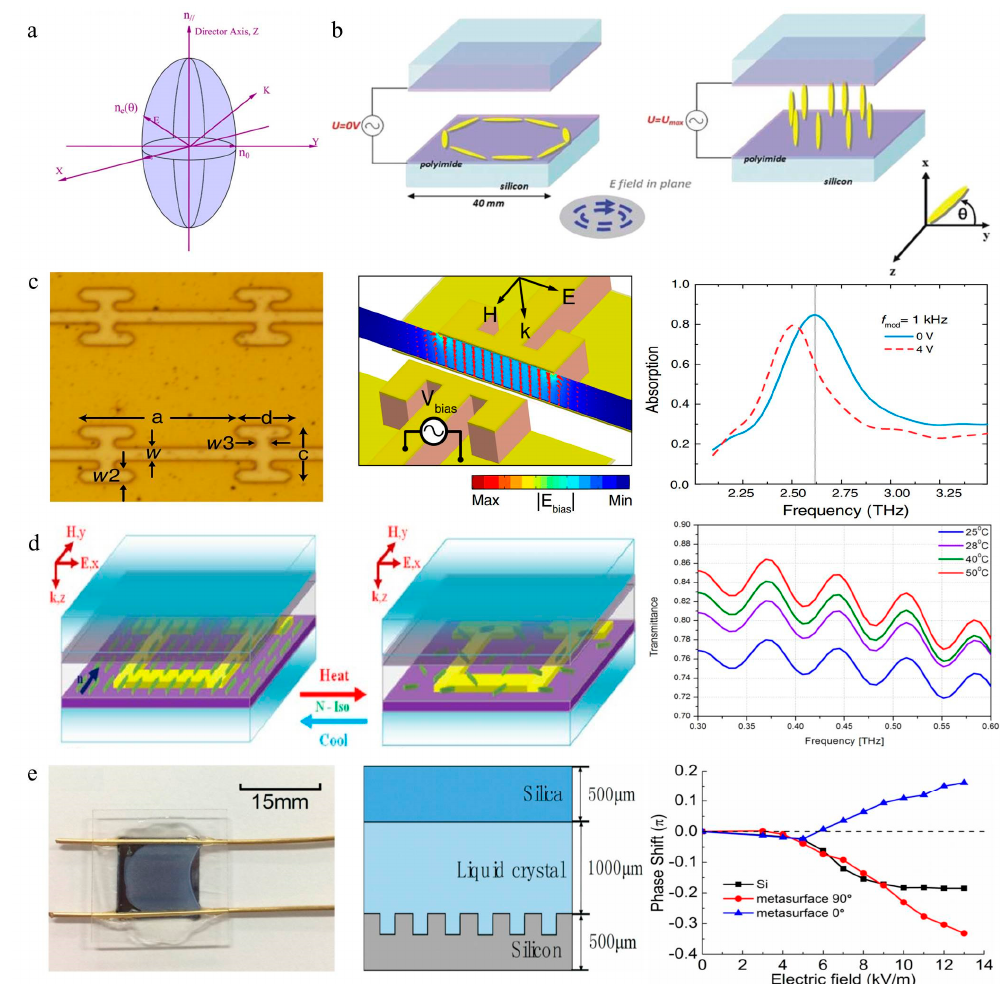
Figure 13. ( a ) Schematic diagram of the interaction between polarized light and liquid crystal molecules. Reproduced with permission from [153], copyright Elsevier, 2009. ( b ) Structure of the electrical adjustability of liquid crystal molecules. Reproduced with permission from [143]. ( c ) The device consisting of an electrically controlled liquid crystal and metamaterial absorber structure provides an absorption tuning of 30% at 2.62 THz. Reproduced with permission from [142], copyright American Physical Society, 2013. ( d ) Schematic diagram and resulting temperature control structure combining the liquid crystal and metamaterial transmission modulator. Reproduced with permission from [151]. ( e ) Electrically controlled phase shifter composed of the liquid crystal and metasurface can obtain phase shifting with varying electric field power. Reproduced with permission from [28].